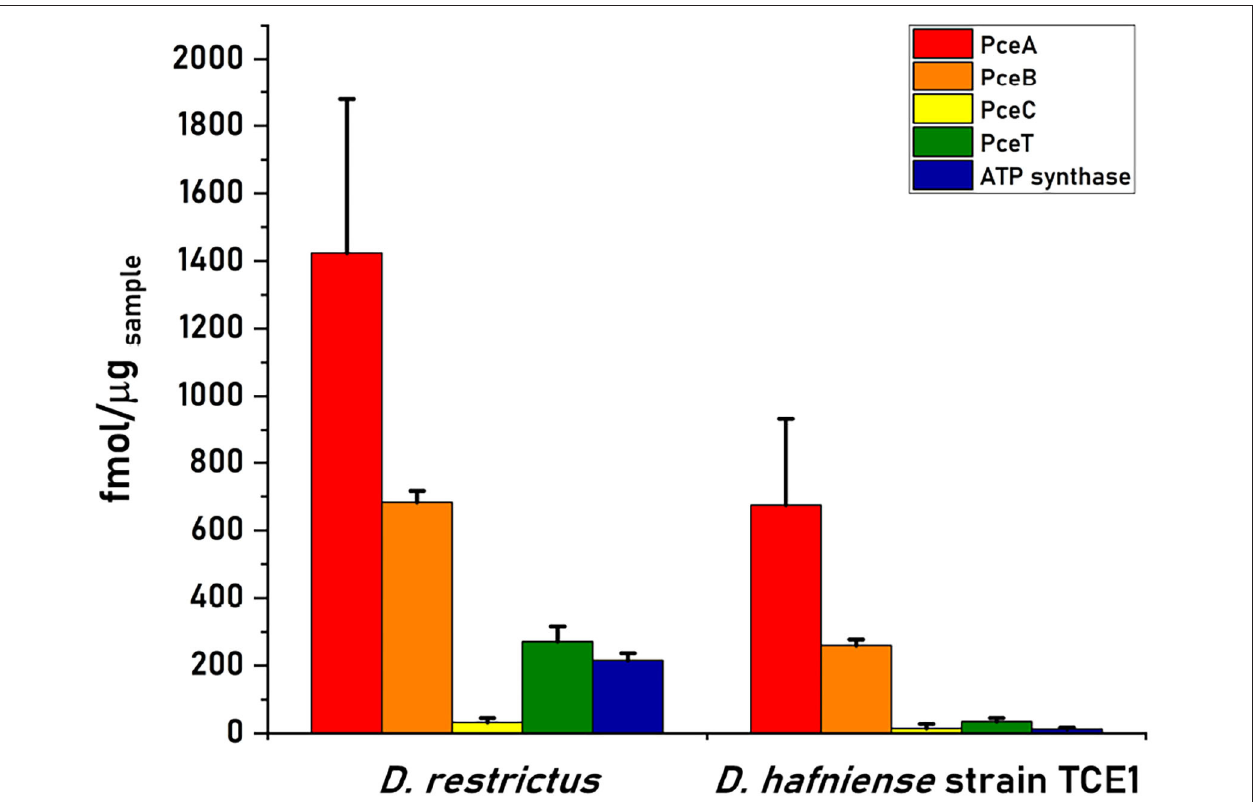
FIGURE 3 | Quantitative proteomics analysis of Pce proteins and the F1 α -subunit of the ATP synthase in cell-free extracts (CFE) from D. restrictus and D. hafniense strain TCE1. This graph shows the results of one biological replicate and is representative of the trend also observed for the second replicate (see Supplementary Table 2 ). The concentration of each protein was calculated by averaging the values obtained for the selected peptides in technical triplicates. Error bars indicate the calculated standard